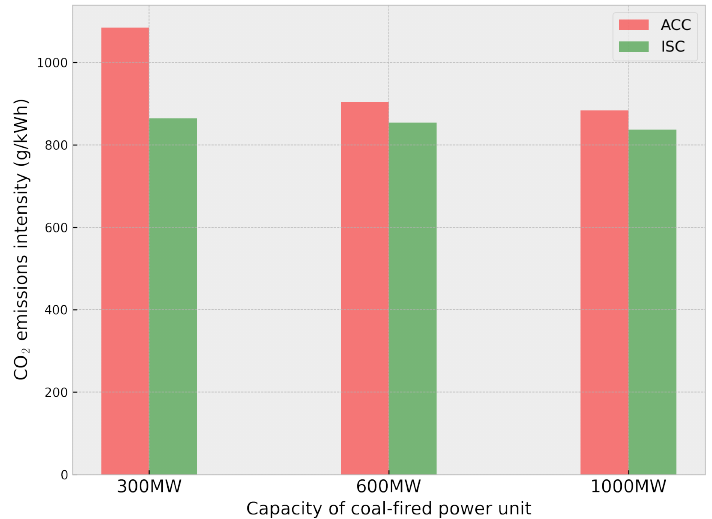
Figure 7. Comparison of the emission intensity of different